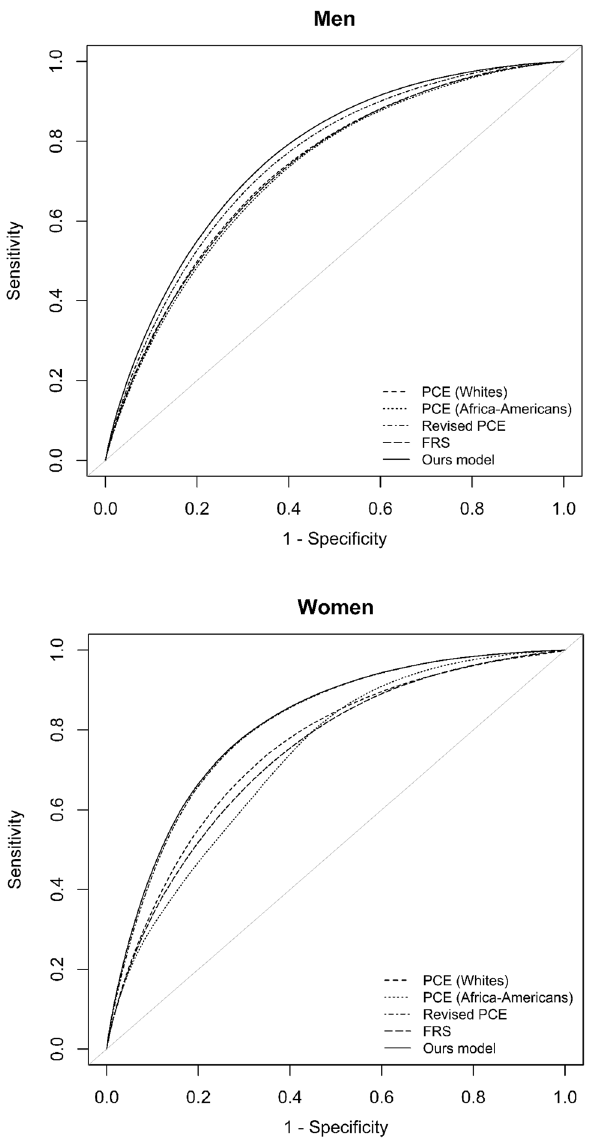
Figure 1. Comparison of the area under the receiver operating characteristic curve (AUROC) of the Framingham risk score (FRS), pooled cohort equation (PCE), and our